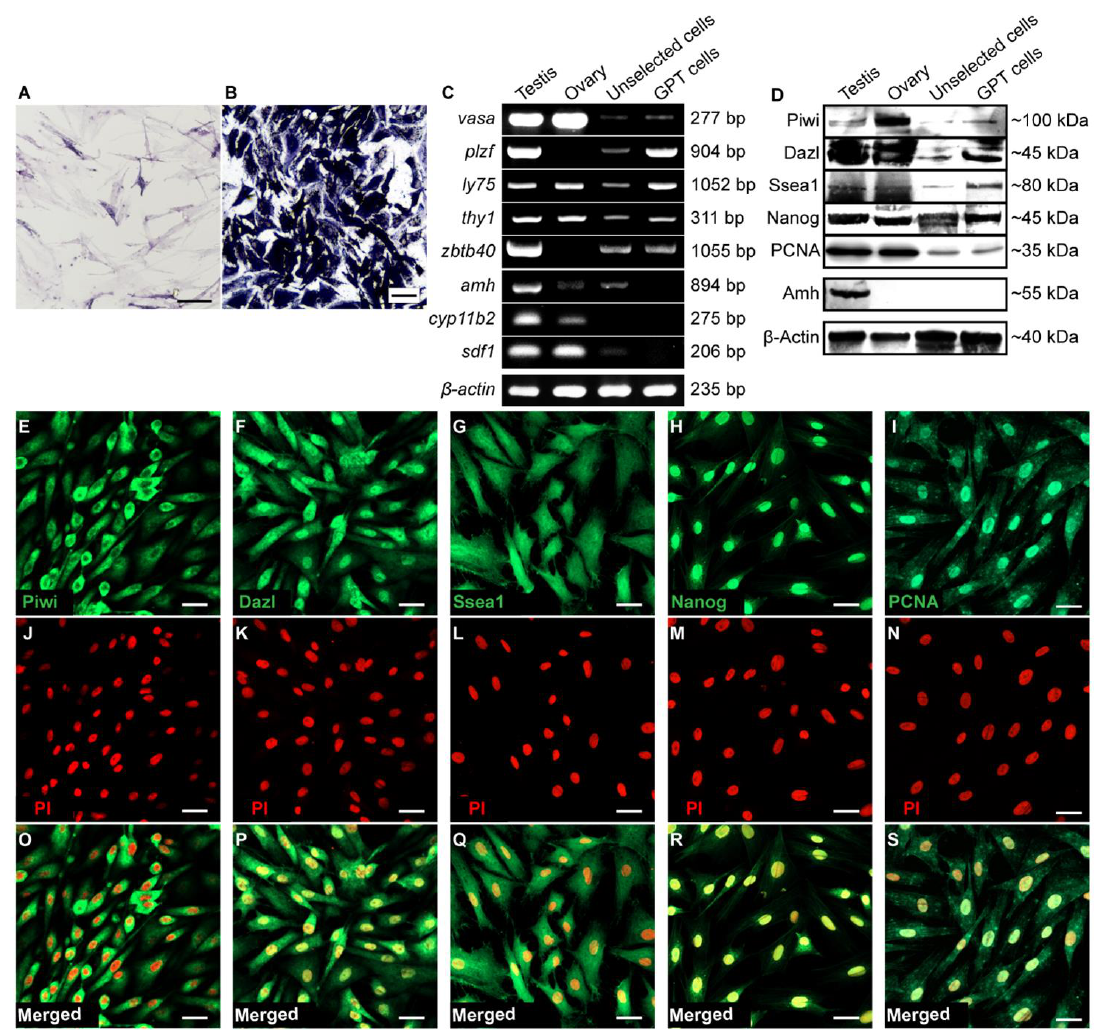
Figure 2. Expression of germ cell markers and pluripotency markers in GPT cells. ( A ) Alkaline phosphatase staining in the testicular cells cultured over 200 days. ( B ) Alkaline phosphatase staining in GPT cells. ( C , D ) Gene expression analysis in GPT cells via RT-PCR and western blotting. The cDNA and protein samples included testis, ovary, the testicular cells cultured over 200 days (unselected cells), and GPT cells. The β -actin was used as an internal control. ( E – I ) Fluorescent immunostaining analysis of Piwi, Dazl, Ssea1, Nanog, and PCNA in GPT cells. ( J – N ) Nucleus was counterstained with propidium iodide (PI). ( O – S ) Merge images. Scale Bars: 50 μm in A and B, 20 μm in ( E – S ).